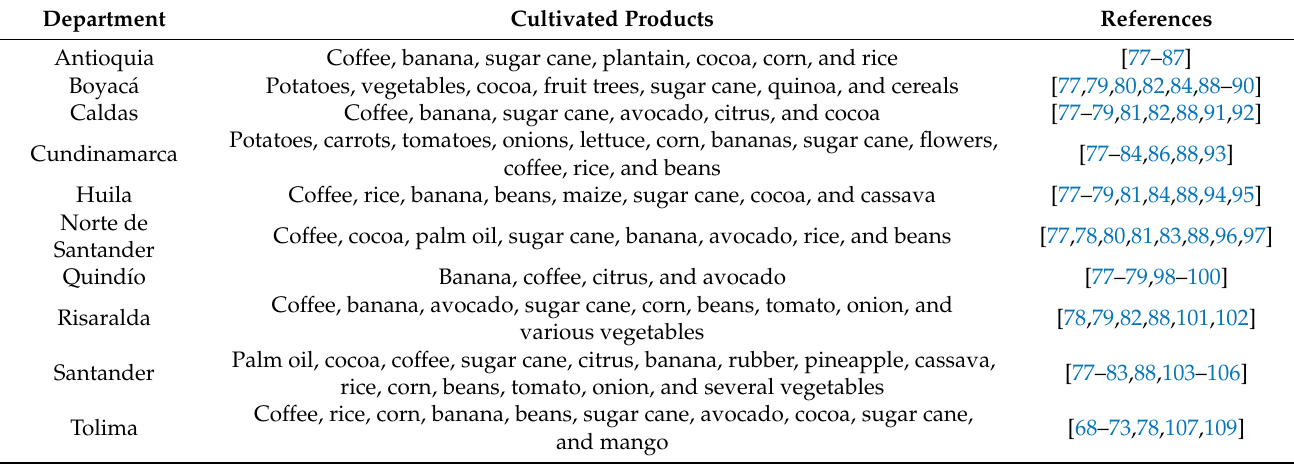
Table 9. Andean region.